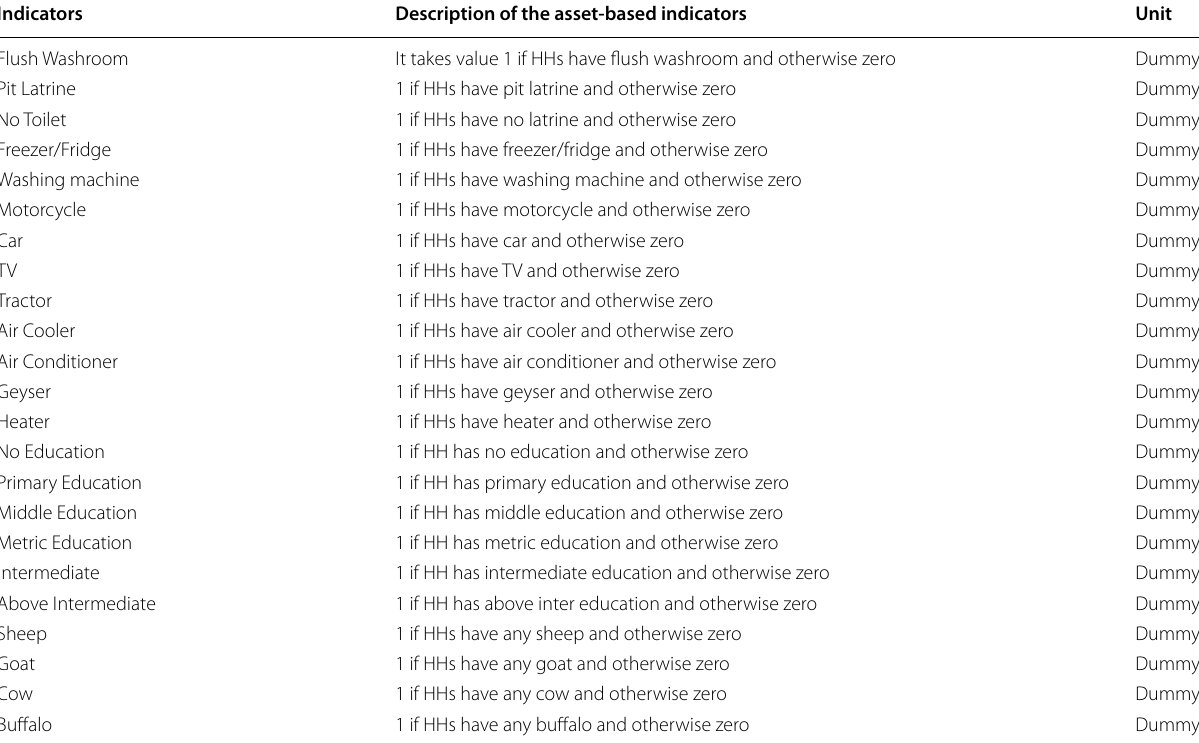
HHs stands for households, whereas HH stands for household